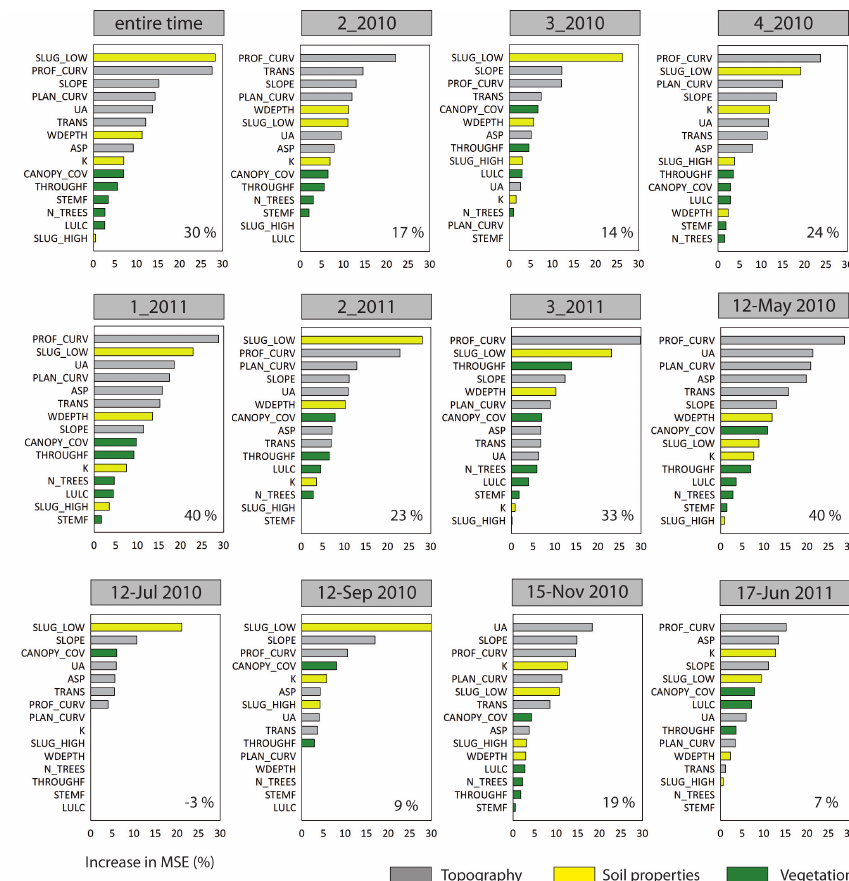
Fig. 5. Variable importance plots of random forest models predicting the water table response variable WT NORM for different temporal scales (entire time, seasonal scale, and event scale). The x-axis displays the percentage of increase in mean square error (MSE) when the data for that predictor are permuted randomly while all others are held constant. The number in the lower right corner of each variable importance plot is the percentage of explained variance for that random forest